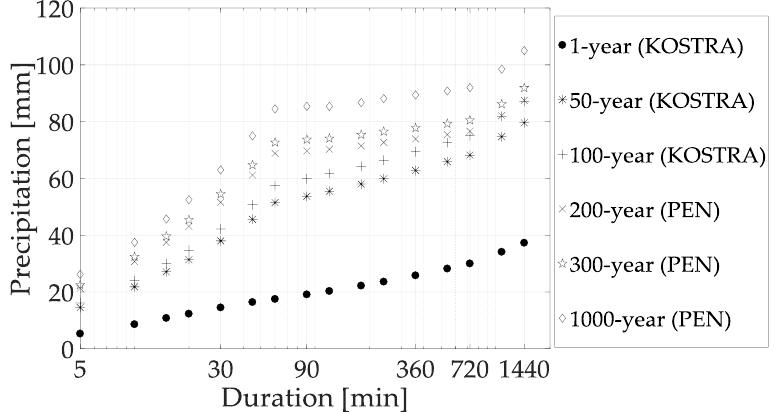
Figure 3. Precipitation values in mm for various durations (in min) and various return periods. PEN method used to extrapolate precipitation values above 100-year return period. Data source: KOSTRA-DWD 2000 (Kulmbach: Column 47, Row 67).